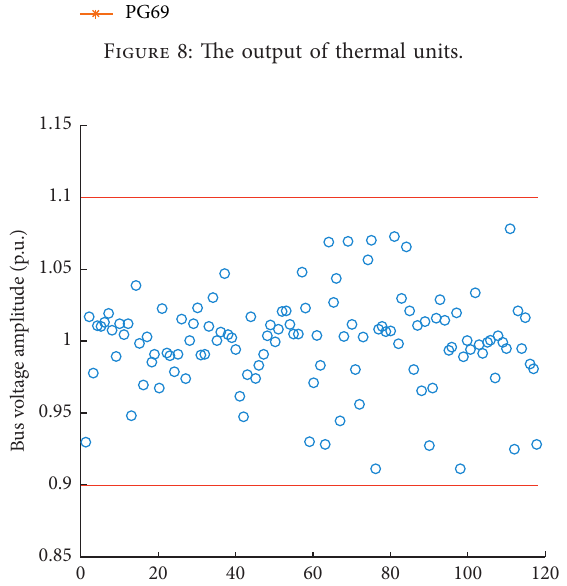
Figure 9: The bus voltage level of the system in a certain period T � 8.